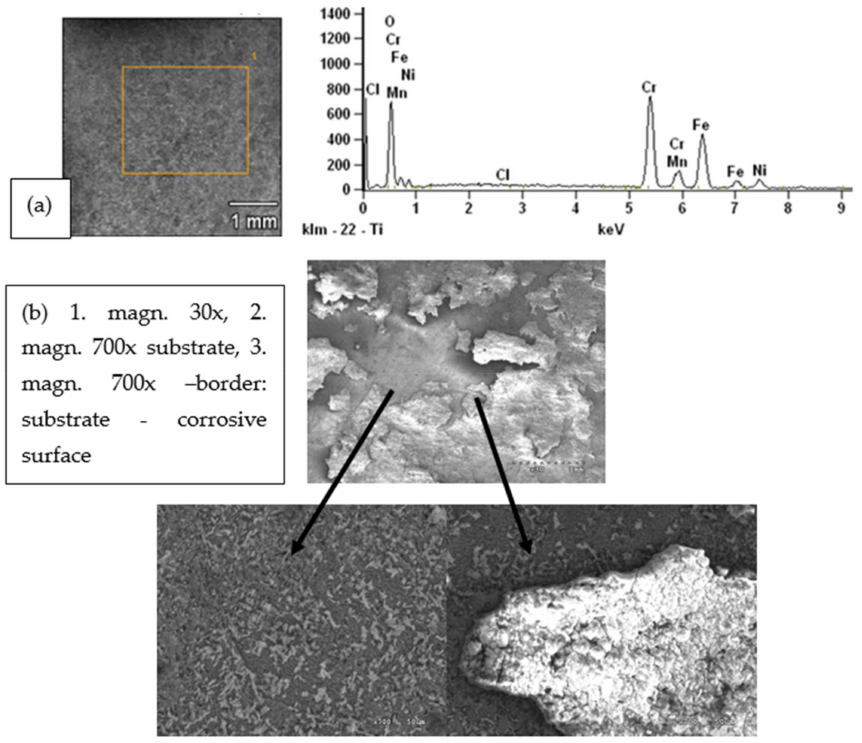
Figure 17. ( a ) The chemical composition of the 50H21G9N4 valve steel surface in the pt1 surface in the microscopic photo; ( b ) microscopic photo (SEM) of the surface of the St41K boiler